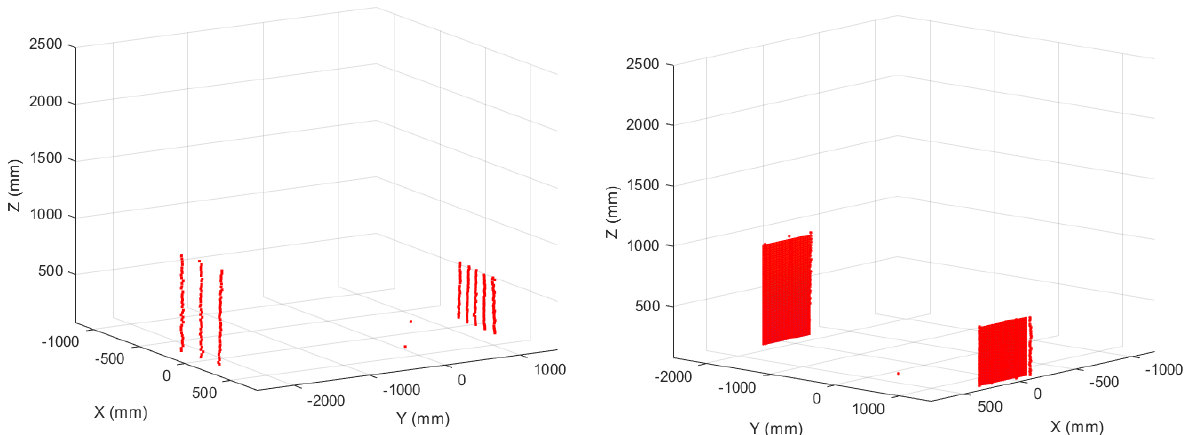
Figure 19. LiDAR mapping of the simulated landing field with two obstacles.